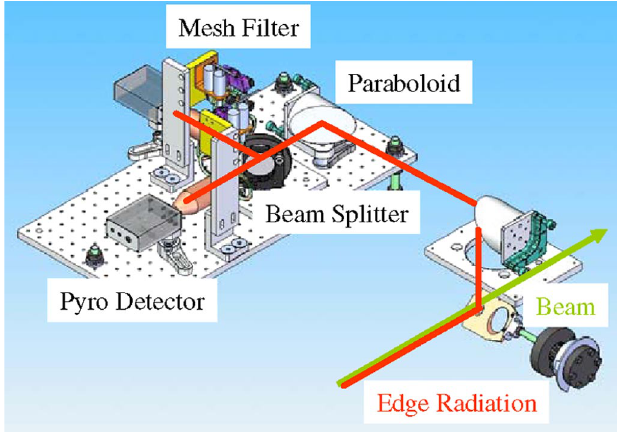
FIG. 24. (Color) A computer generated drawing of the BL11 bunch length monitor system following